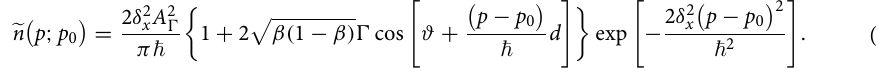
n ( p ) , for fixed values (cid:31)